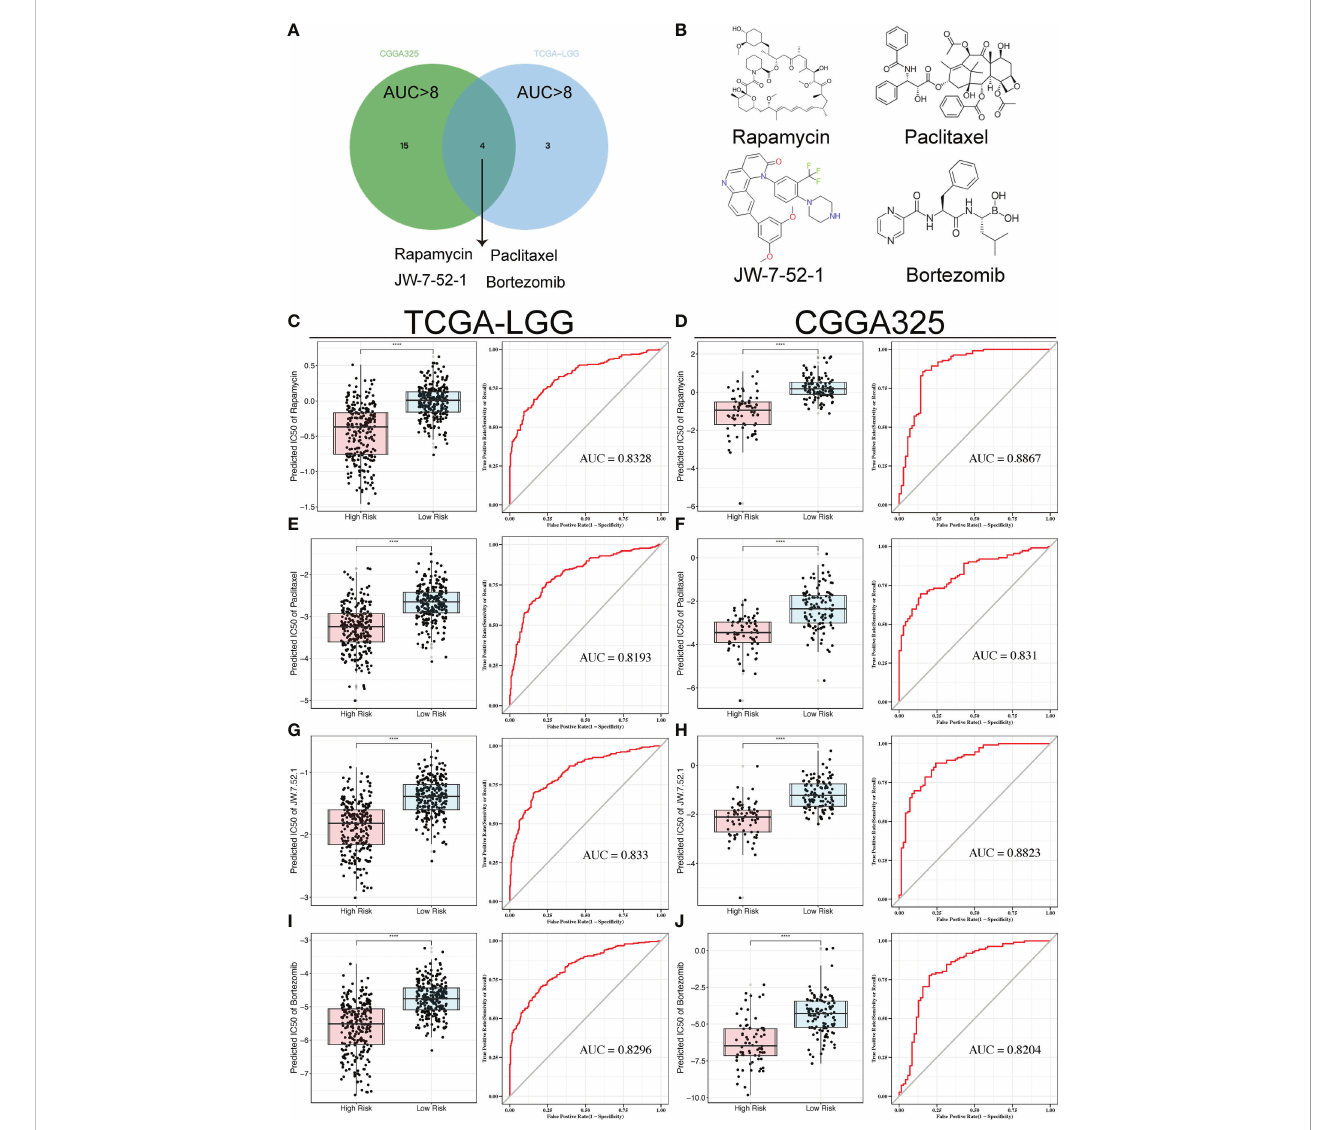
FIGURE 7 Drug sensitivity analyses in both cohorts. (A) Venn diagram showing the overlaps of the sensitivity to the top four drugs. (B) Tomographs of the structures of the four candidate drugs. (C-J) Box plots displaying the predicted IC50 of the four drugs in the high-risk and low-risk groups in the TCGA- LGG and CGGA325 cohorts, including Rapamycin (C, D) , Paclitaxel (E, F) , JW-7-52-1 (G, H) , and Bortezomib (I, J) ; ROC analyses of the risk scores for the prediction of drug response.